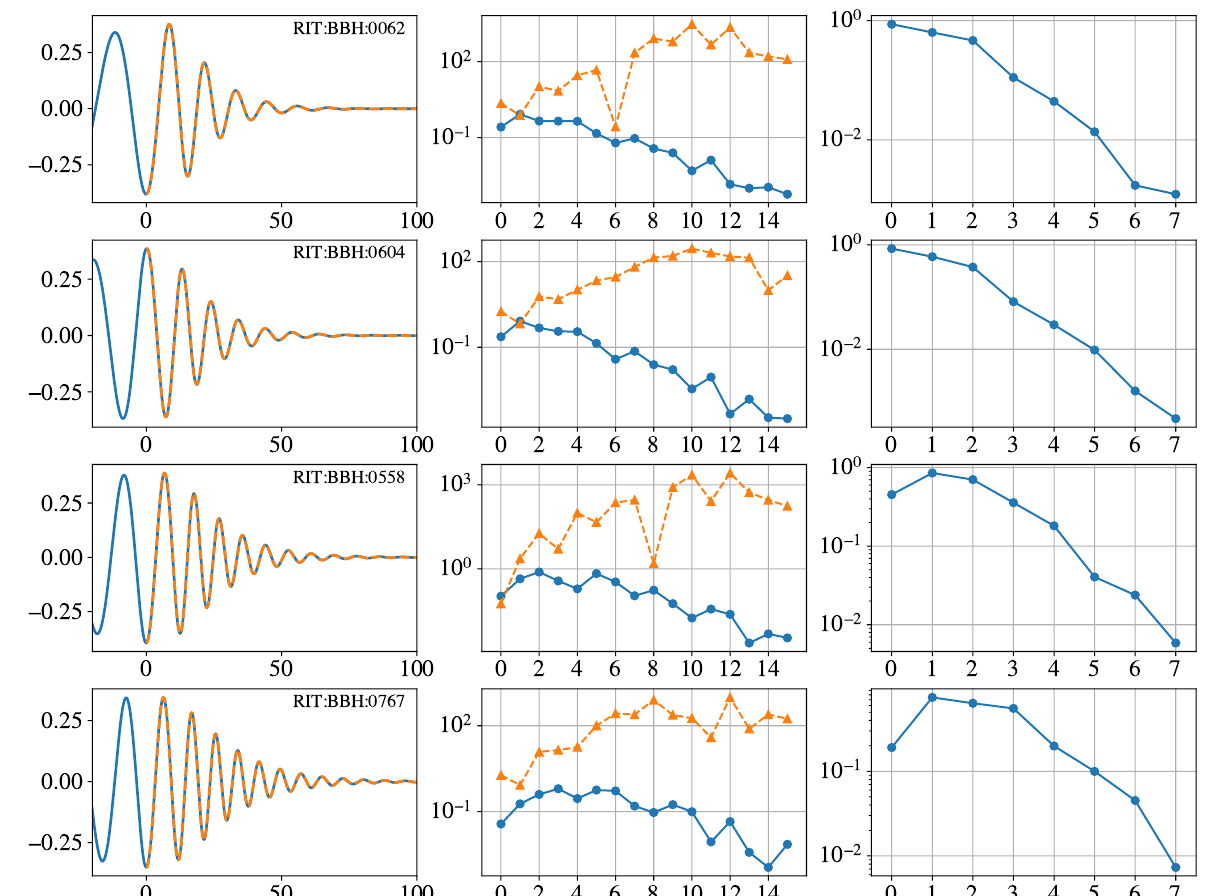
Figure A4. The waveforms and fitting coefficients of samples of RIT data listed in Table A1. The plots in the ( left column ) show the real part of the ( (cid:96) = 2, m = 2 ) spheroidal harmonic mode (the blue solid line) and the QNM fit to the model with the orthonormal set given in Equation (37) (the orange dashed line). The plots in the ( center column ) present the absolute values of the fitting coefficients for ˜ C (cid:96) m (the blue filled circles) and C (cid:96) m (the orange filled triangles). The plots in the ( right k k column ) show ∆ n in Equation